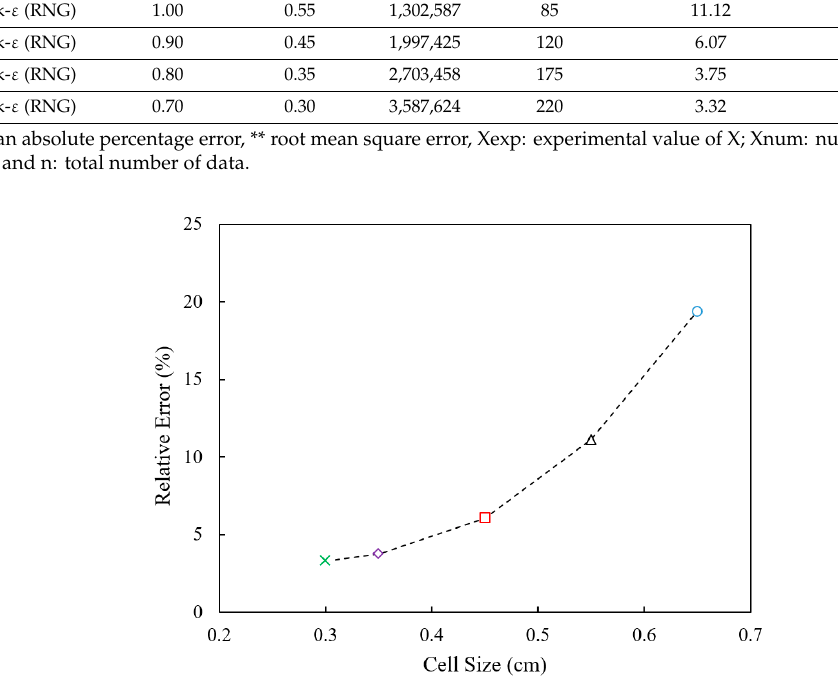
Figure 4. Variations of the relative error of the free surface profiles versus cell size.